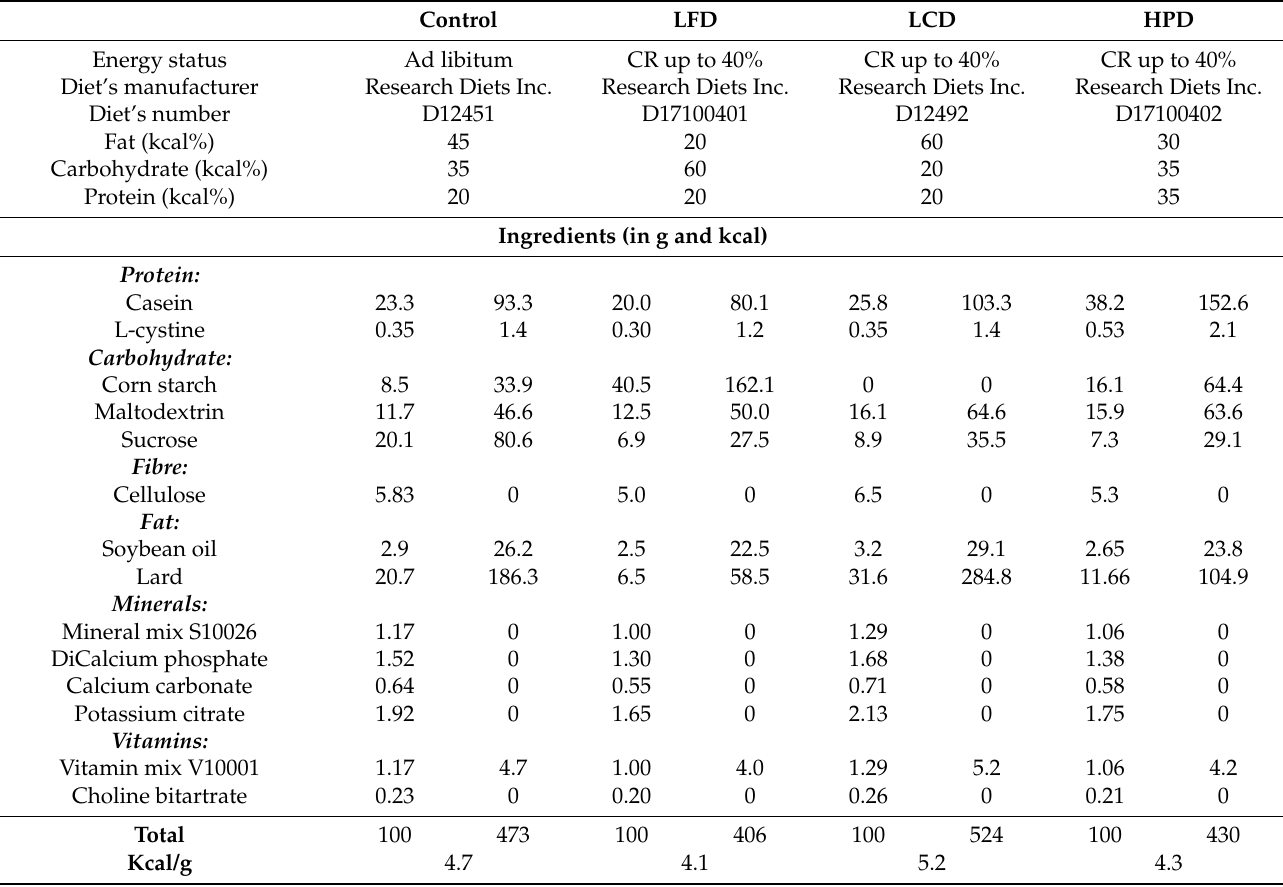
Table 1. Nutritional characteristics of the obesogenic control, low-fat (LFD), low-carbohydrate (LCD) and high-protein (HPD) diets used in the